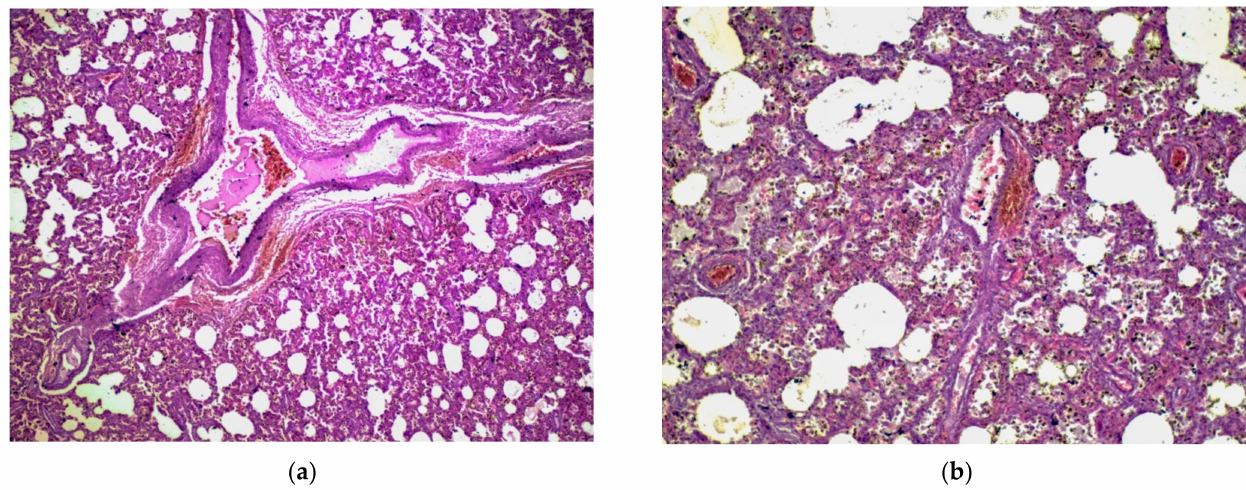
Figure 8. HE stain of infant pulmonary tissue, suggestive of viral interstitial lesion: ( a ) 100 × —severe vascular stasis and thick alveolar septs; ( b ) 400 × —vascular thrombosis, infiltration of lung tissue with inflammatory cells, especially in the thick alveolar